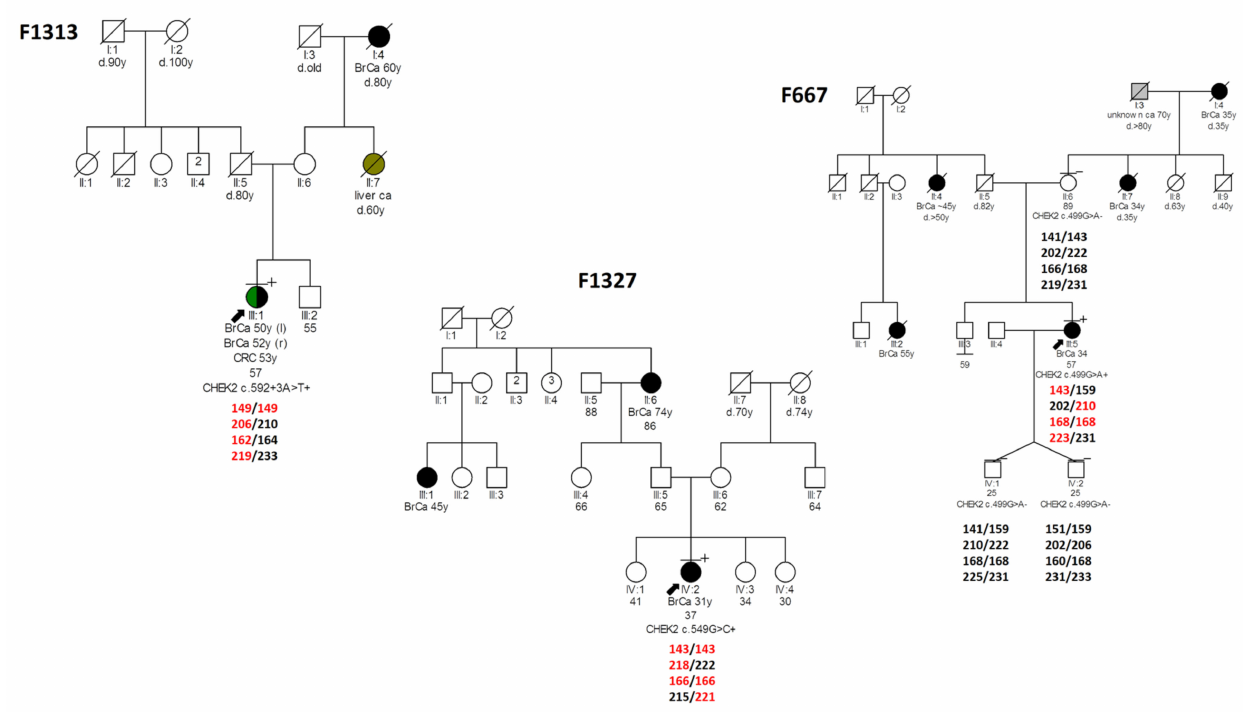
Figure 4. Pedigrees of families, members of which carry the CHEK2 founder pathogenic variants, where haplotype analysis results are shown. Probands are represented by arrows. Disease-associated alleles are shown in red. Abbreviations used: ca, cancer; BrCa, breast cancer; CRC, colorectal